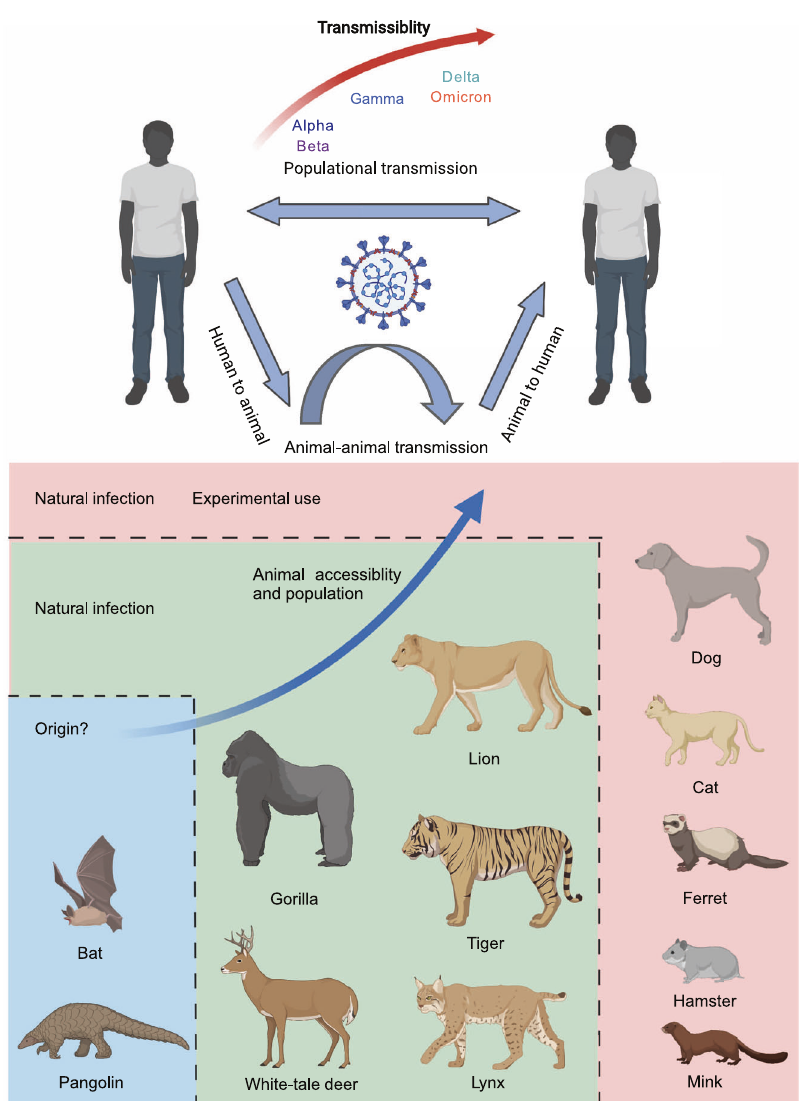
Fig. 11 Change in SARS-CoV-2 variants transmissibility and patterns for transmission among human and animal populations. The transmissibility of SARS-CoV-2 VOCs increased over strains during human-to-human transmission. And substantial evidence reveals the SARS- CoV-2 transmission from humans to various mammalian animals as reported by OIE (https://www.oie.int/en/what-we-offer/emergency-and- resilience/covid-19/). There have been cases reporting the transmission between animal populations and animals to humans, making wild animals or pets a potential reservoir for viral preservation and evolution. BioRender is used to generate this fi gure to demonstrate an enhanced transmission of SARS-CoV-2 variants to Besides the study on the general transmission among animals, animal populations in wild conditions. SARS-CoV-2 variants manifested an inclination of broad host spectrum tropism. In vitro studies have shown that various VOCs displayed higher af fi nity to murine ACE2, and mice challenged with the authentic virus of Alpha variant developed pathological changes along the respiratory tract compared to the ancestral strain. 409 The primary outcomes suggested that the host tropism of SARS-CoV-2 variants in animals tends to expand. Generally, SARS-CoV-2 variants manifested an increase in trans- missibility among the human population, 410 – 412 and the Omicron variant, with its remarkable evasion from neutralization, displayed an even stronger populational prevalence. 374,413 Furthermore, the fi ndings of animal infection of SARS-CoV-2 further displayed that the virus enjoyed broader transmission due to the wider host tropism and huger reservoir for viral evolution, which could facilitate the emergence of SARS-CoV-2 variants and exacerbate the burden of global cost in containing the pandemic. More evidence was required